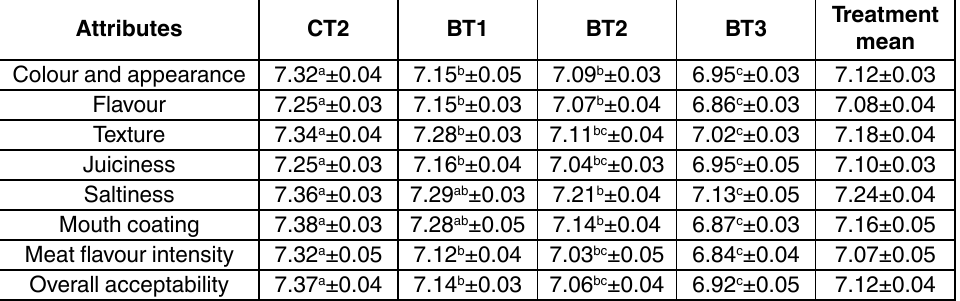
table 5. Effect of pearl millet flour on sensory scores (Mean±SE) of chicken